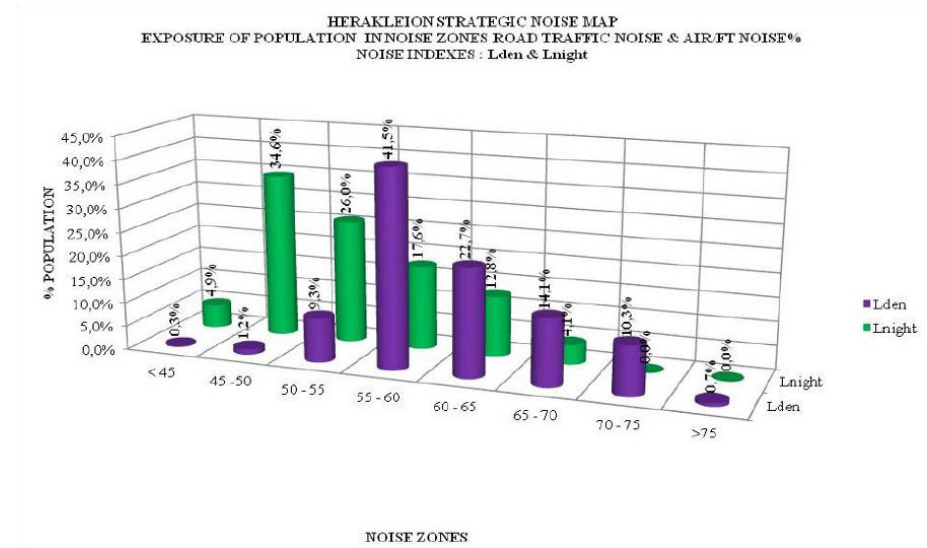
Fig. 5. Herakleion SNM 2012 – Population exposure - Noise indices L den & L night